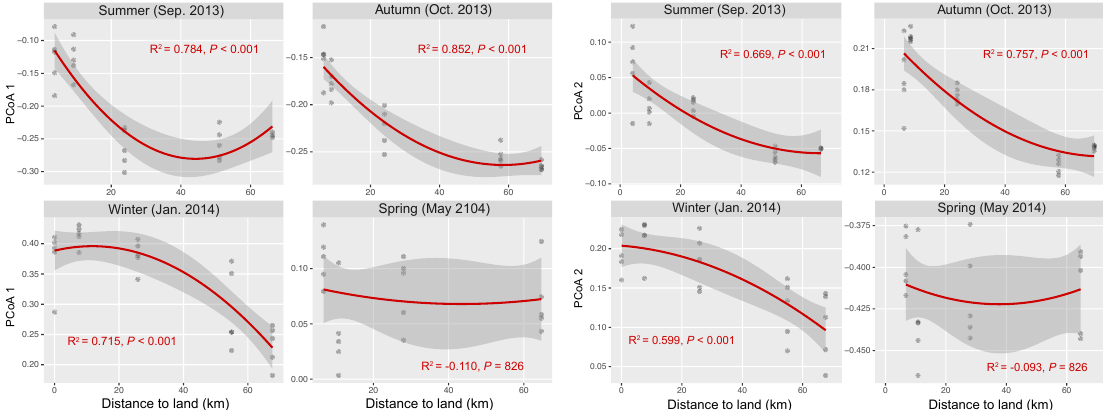
Figure 4. Correlations between bacterial community composition (indicated by the first two coordinates of PCoA) and the nearest distance to land of the stations in each season. The red lines present binomial fitting.